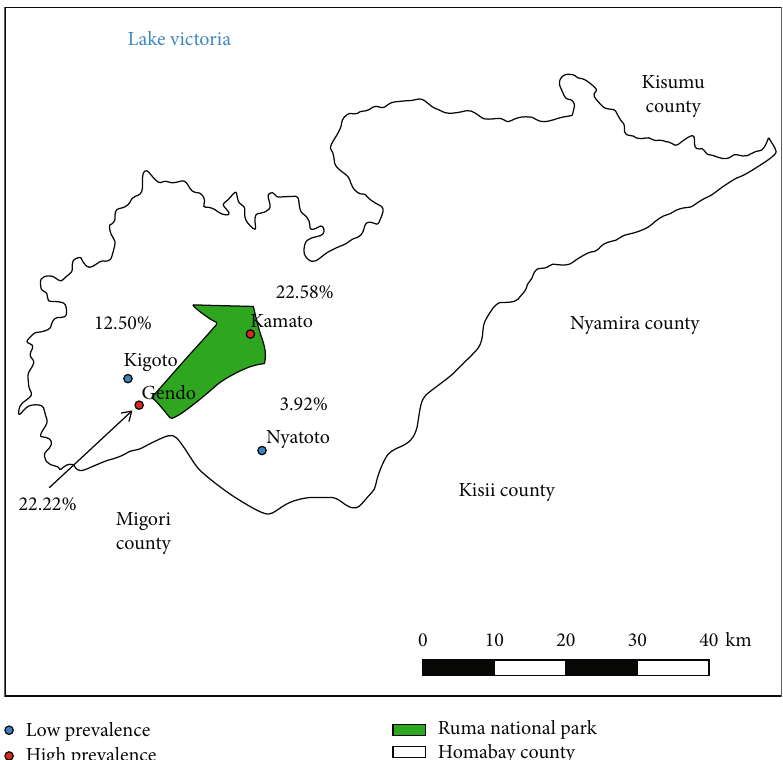
Figure 1: Map of Homa Bay County showing the location of study villages in Lambwe-Valley, with the prevalence detected from each site in Table 1: Species-speci fi c primers used for Trypanosoma identi fi cation. Trypanosoma species